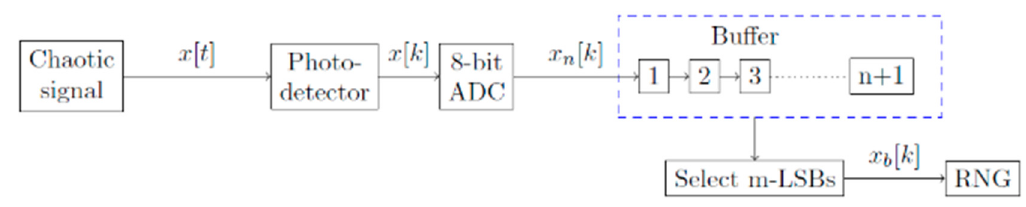
Figure 4. Block diagram of a random number generator from a chaotic signal.